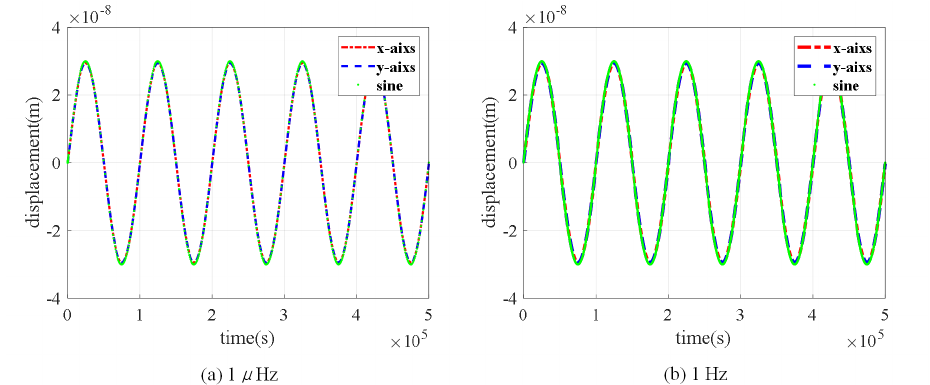
Figure 11. Tracking of drag − free with disturbance of ( a ) 1 µ Hz and ( b ) 1 Hz.